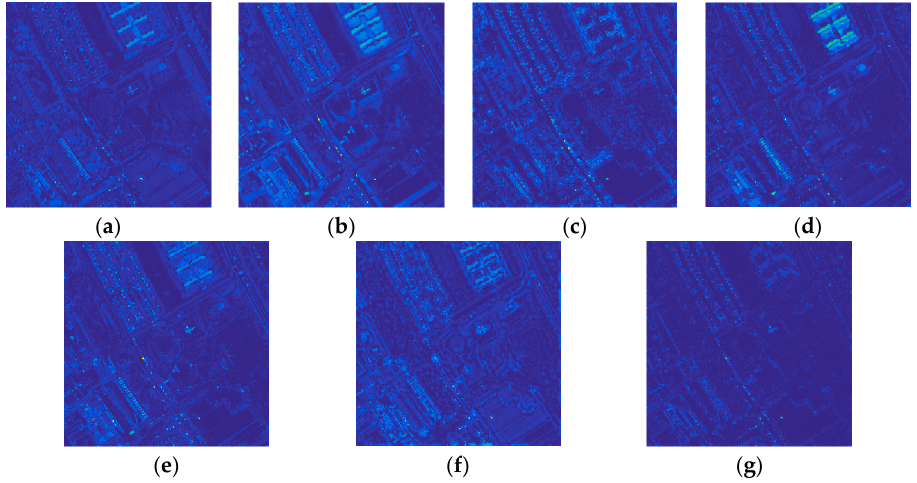
Figure 6. Error images of the competing methods for Pavia University dataset. ( a ) PCA; ( b ) GFPCA; Table 2. Quantitative results of different fusion methods for Pavia University dataset.